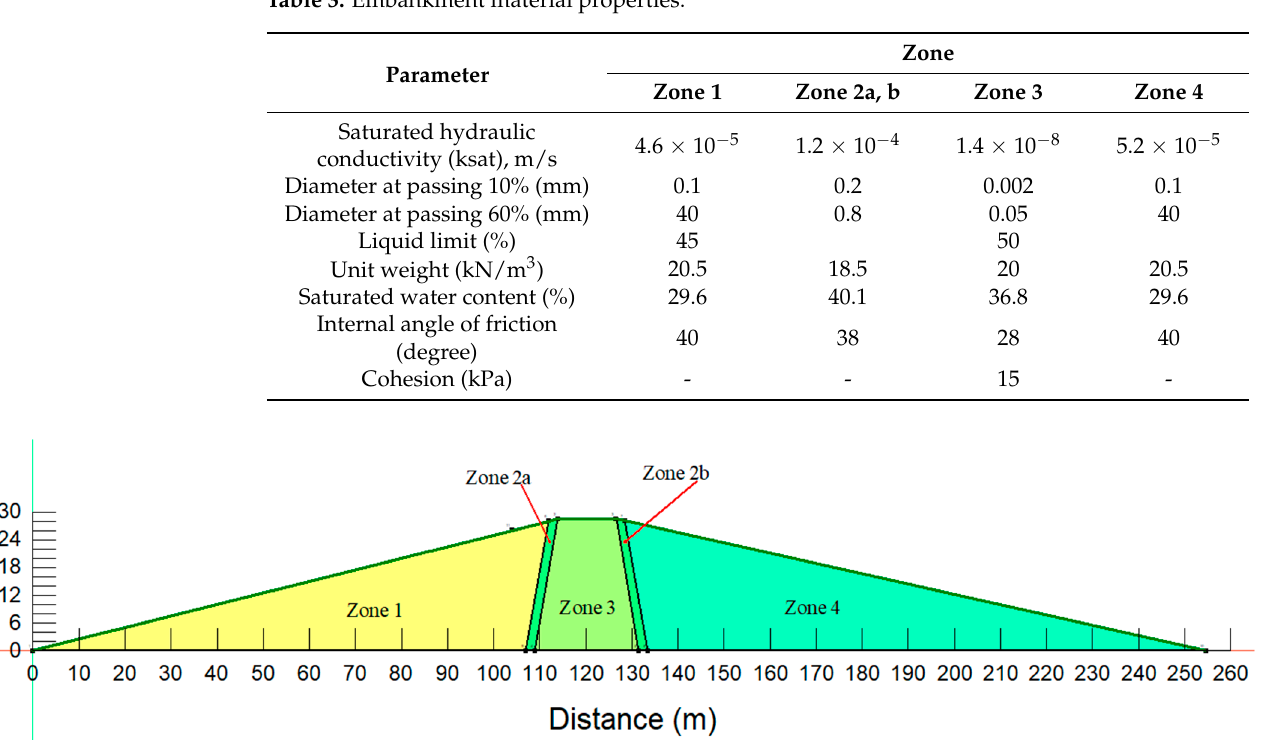
Figure 2. Embankment geometry.